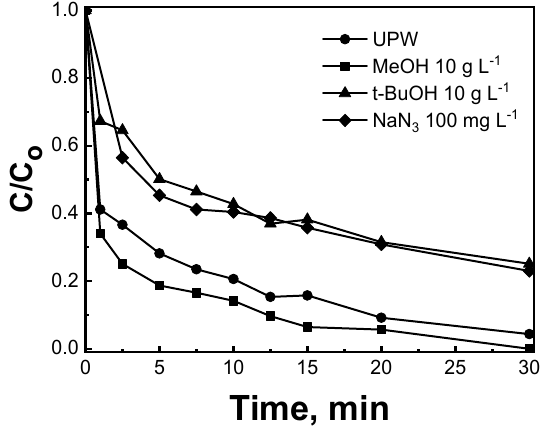
Figure 13. Effect of scavengers on the degradation of 0.5 mg L − 1 SMX with 100 mg L − 1 biochar and 250 mg L − 1 SPS in UPW and inherent pH.